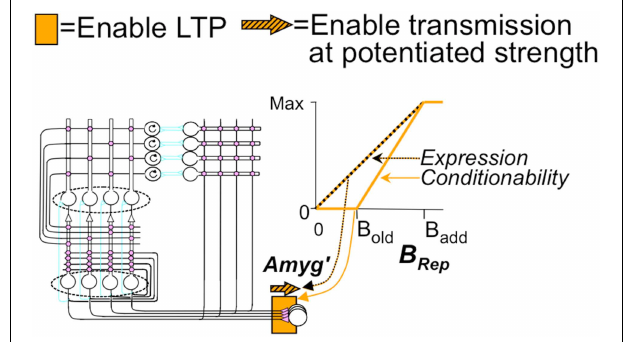
FIGURE 5 | Fear conditioning and expression modes. Susceptibility to LTP (conditionability) and transmission at levels determined by established LTP are neuro-modulator controlled as shown. Explained in